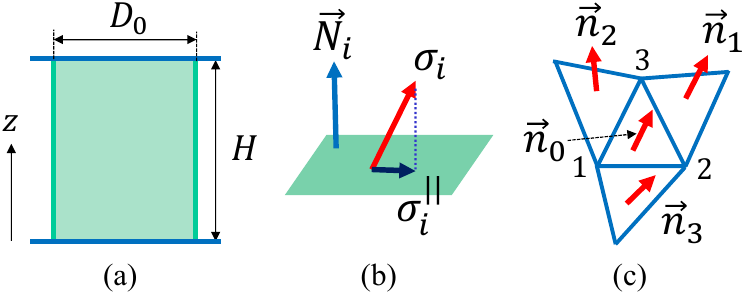
Figure 3. ( a ) The height H and diameter D 0 of a cylinder, ( b ) the unit normal vector N i of the tangential plane at the vertex i , the tangential component σ n i of the triangles i (= 0,1,2,3 ) used in S 2 of Equation (4). σ is identified with − σ because of the non-polar